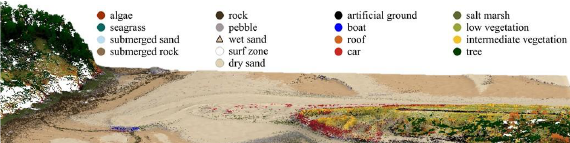
Figure 8. Extract of the resulting 3D classification: the sandy dune of Sables d’Or les Pins and its